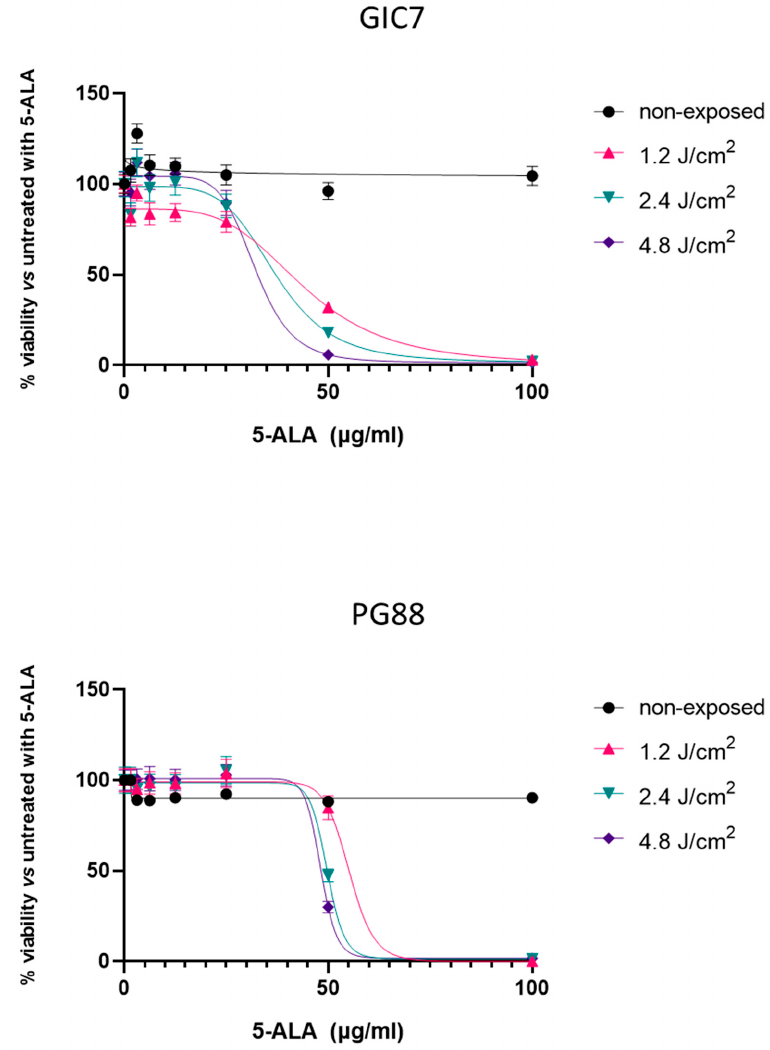
Figure 6. GIC7 (top) and PG88 (bottom) cell viability under different conditions of photodynamic therapy. The plot is representative of three independent experiments performed in both adherent cells in quadruplicate. Irradiation was applied at 1.2–4.8 J/cm 2 . The percentage of cell viability after 5-ALA treatment (0–100 µg/mL) was calculated with regard to control cells without treatment.